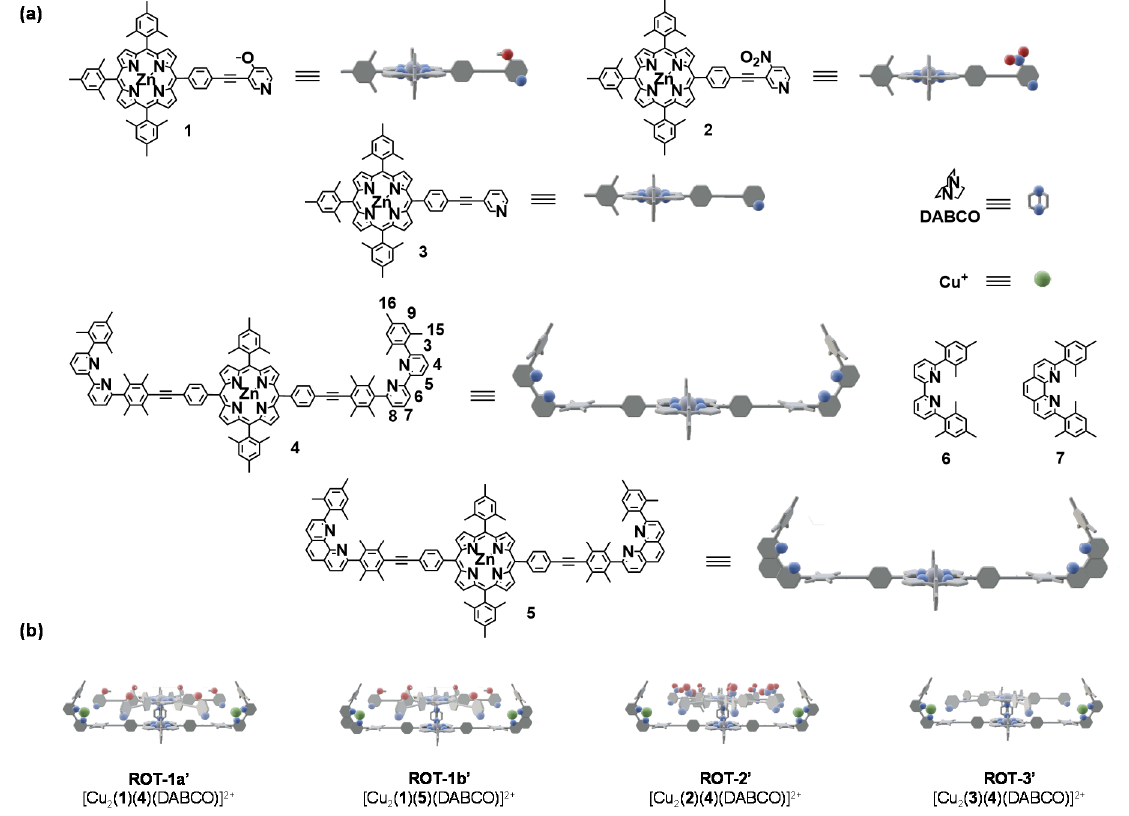
Figure 1. ( a ) All four components of the self-assembled nanorotors and their cartoon representation. ( b ) Cartoon representations of the four-component nanorotors.